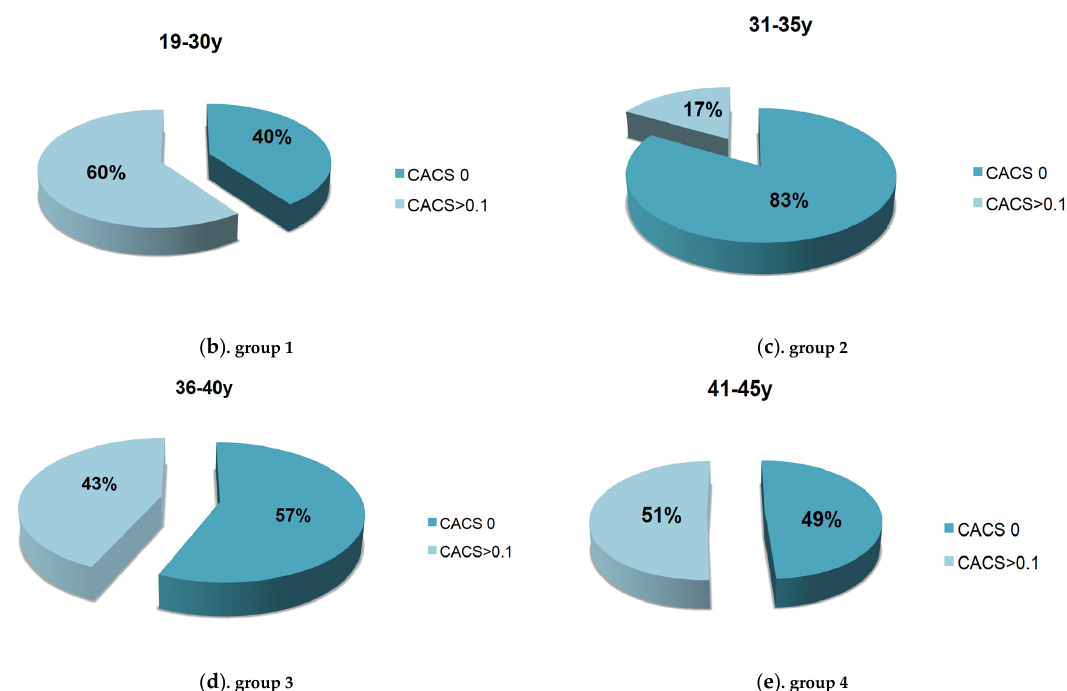
Figure 5. ( a ) High-risk plaque (HRP) in patients without coronary calcium (CACS 0) compared to those with coronary calcium (CACS > 0.1 AU). ( b – d ) . The distribution of high-risk-plaque (HRP) in CACS zero compared to positive CACS > 0.1 AU among different age groups was not different with 63 vs. 36% in patients between 19 and 35 years ( b , c ). In patients >35 years of age, there was a trend towards an increasing prevalence of HRP in those with positive CACS > 0.1 AU. ( d , e ) .